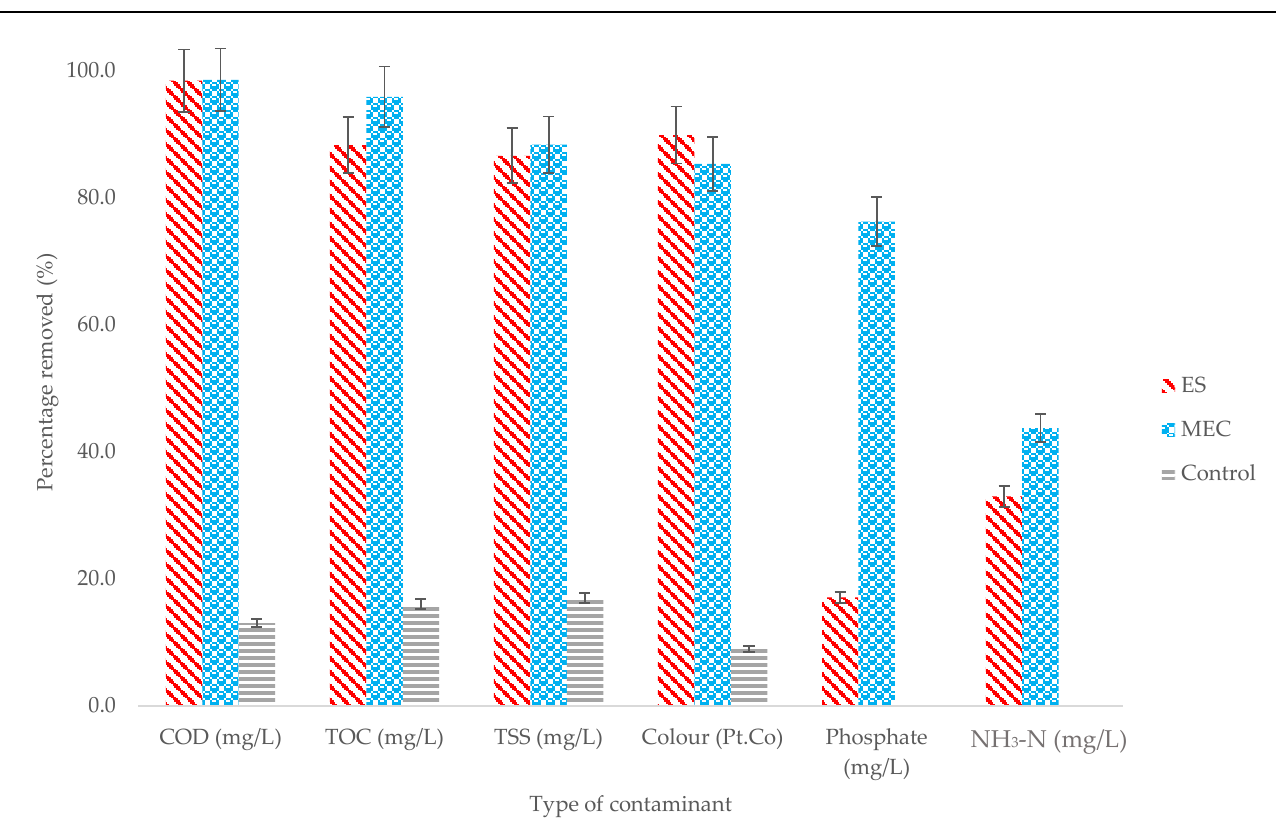
Figure 8. Effect of digester type on decontamination.